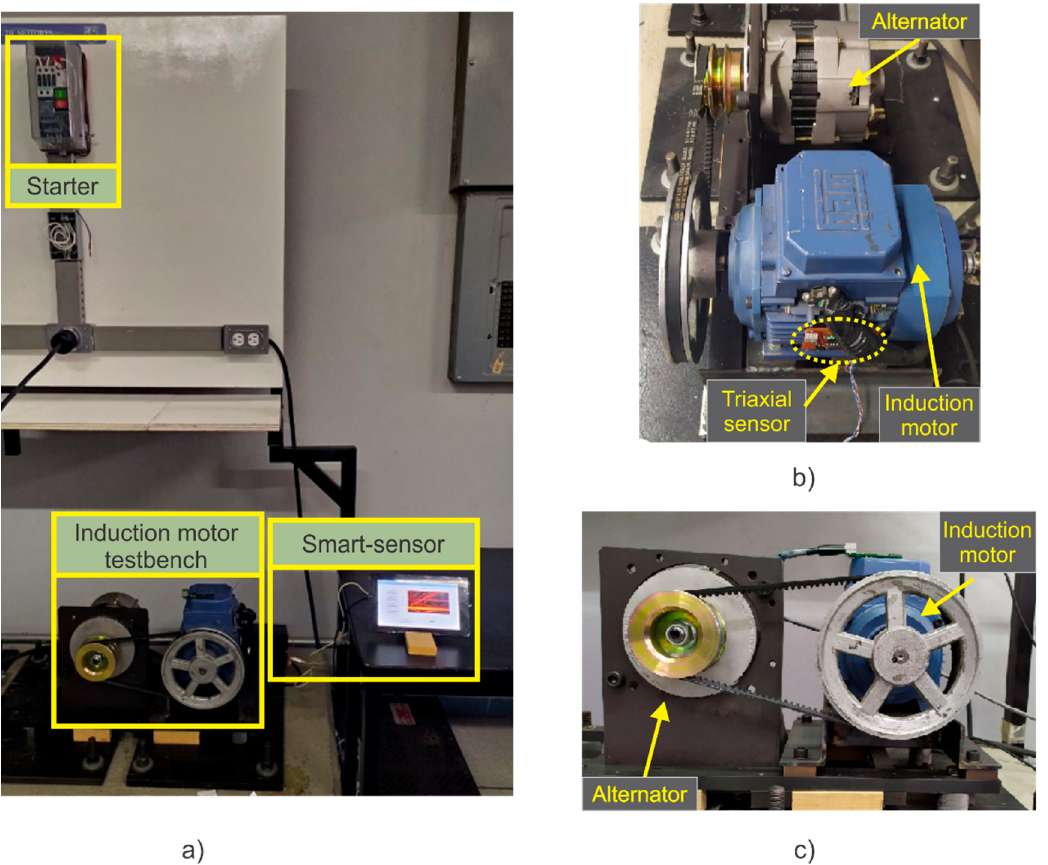
Figure 10. Experimental setup: ( a ) Induction motor testbench, ( b ) side view of the testbench, ( c ) front view of the testbench.